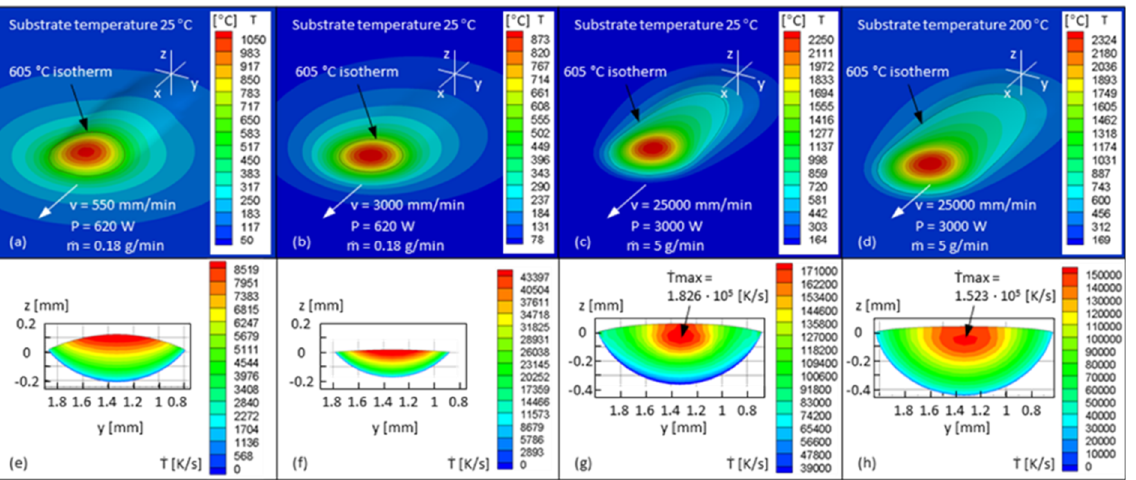
Figure 21 . Results of the simulation of the temperature fields ( a – d ) and the corresponding cooling rates Ṫ on the solidification front of 605 °C isotherm ( e – h ) by changing the travel speed v , laser power P , power feed rate ṁ , and the substrate temperature.